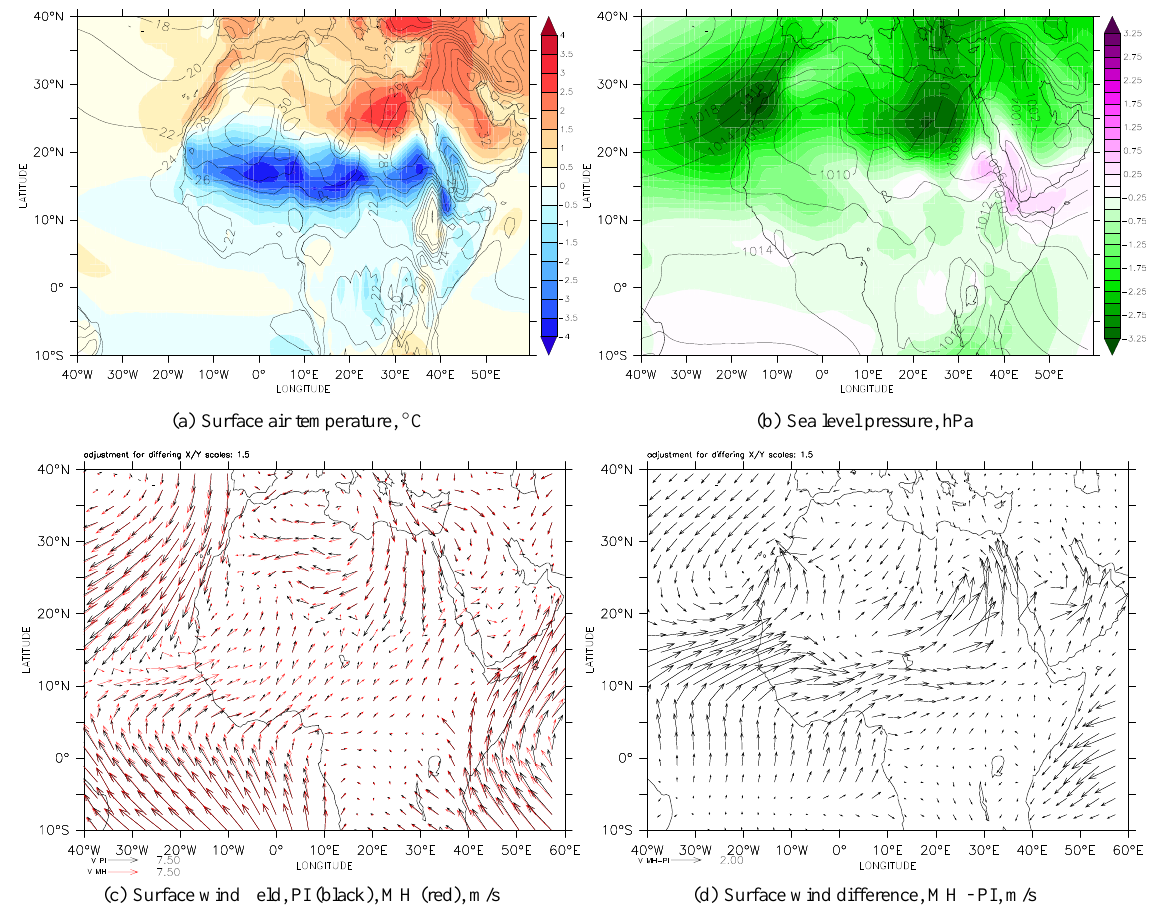
Fig. 7. MH - PI difference in JAS surface air temperature (a, ◦ C) and sea level pressure (b, hPa); contours are PI values, colours indicate differences between MH and PI. (c) shows the PI surface wind field (black) and the MH surface wind field (red), unit length is 7.5 m/s, (d) gives the difference between the MH and PI wind field, unit length is 2.0 m/s.